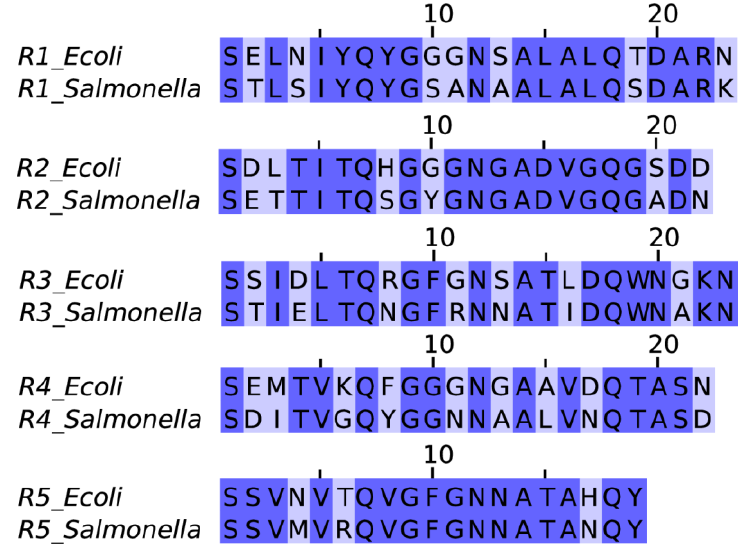
Figure 1. Pairwise sequence alignment between CsgA fragments of E. coli and S. enterica bacteria. The differences in the amino acid compositions are highlighted with light purple.